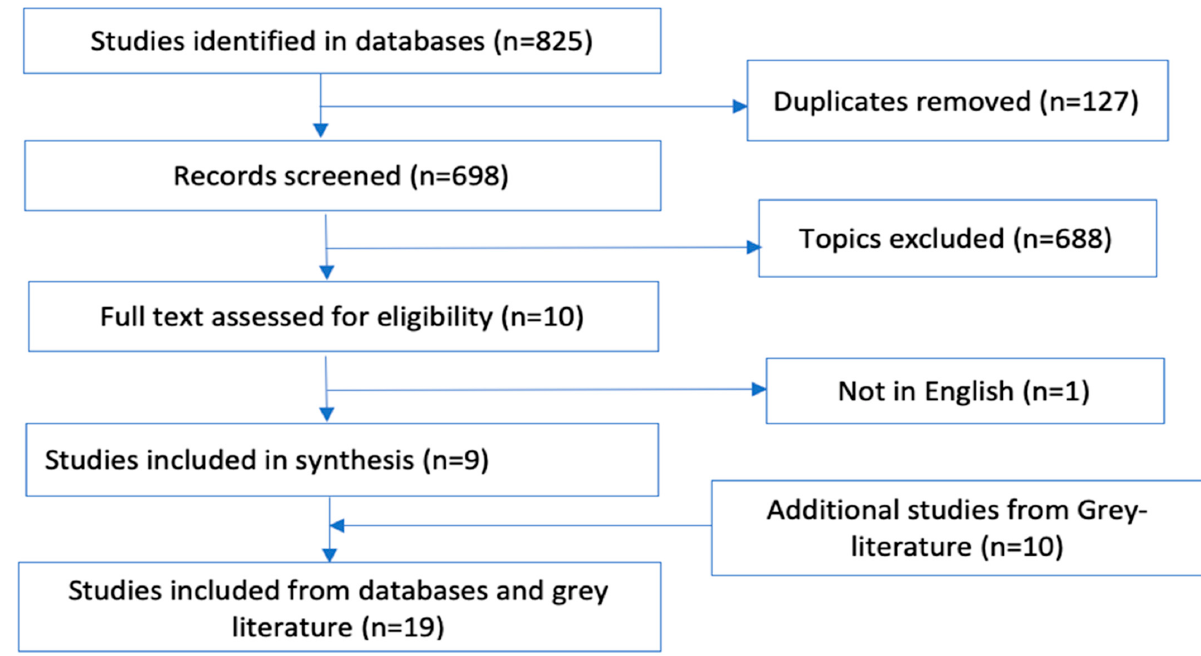
Figure 1. PRISMA summary flowchart of review of HIAs.